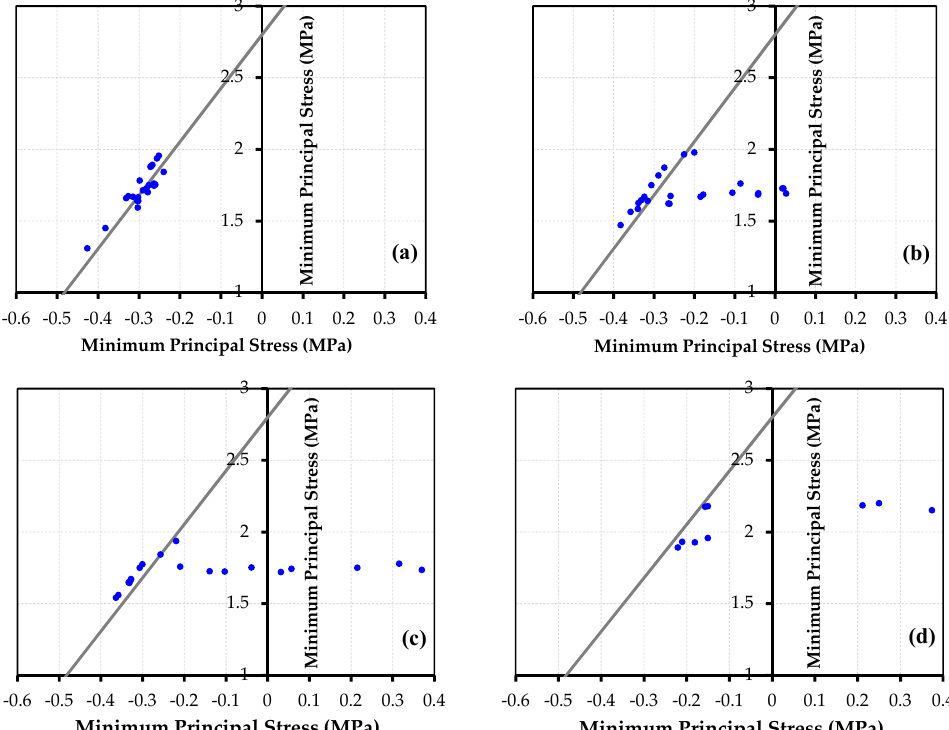
Figure 14. The main stresses in surrounding rock by increasing overburden: ( a ) 0.13H, ( b ) 0.26H, ( c ) 0.53H, and ( d ) 0.93H (gate closure time in all cases was 14 s).